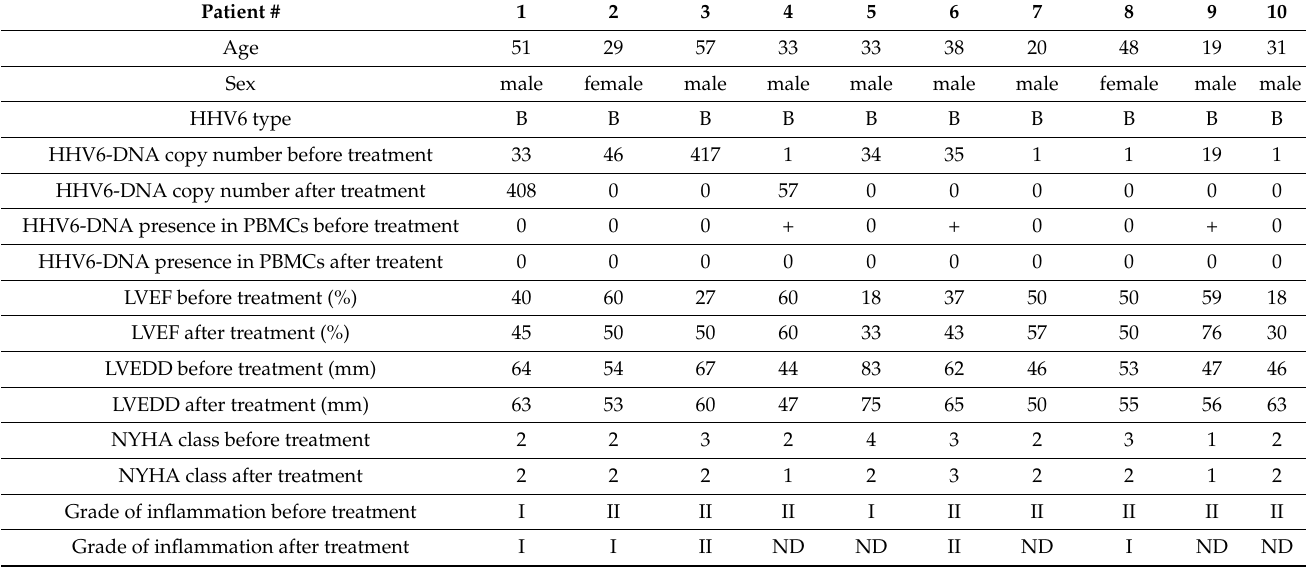
Table 2. Baseline and post-treatment characteristics of the immunosuppression treatment patients. Human herpes virus 6, HHV6; LVEDD, left ventricular end-diastolic diameter; LVEF, left ventricular ejection fraction; NYHA, New York Heart Failure Association functional class; ND, not